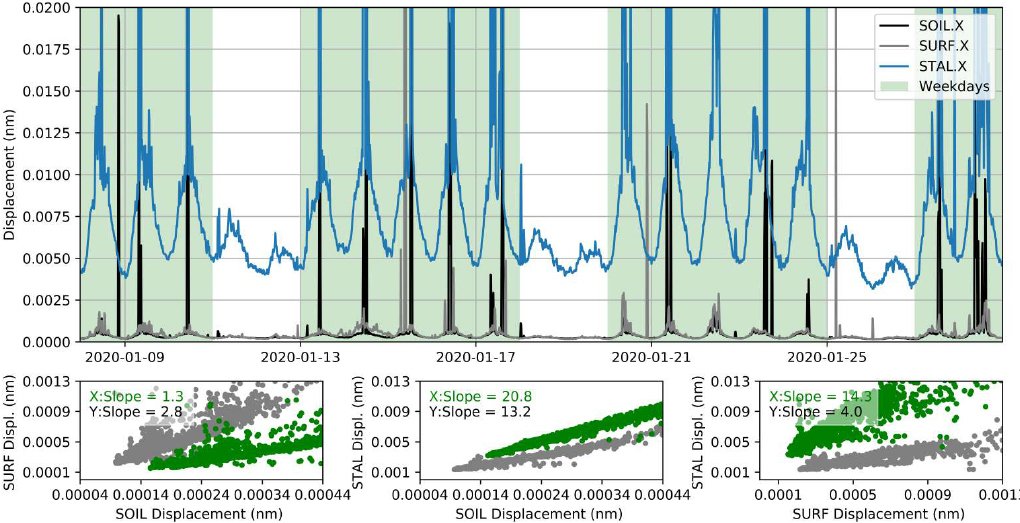
Figure 4. Top : Hourly variations of displacement amplitude (Root Mean Square; RMS) of the ambient seismic noise (11 to 16 Hz, X-component) measured at the surface (SURF, gray) at the base of the stalagmite (SOIL, black) and attached to the stalagmite (STAL, blue), based on [49,50]. Weekdays are indicated by green shading. Bottom : Relation of the displacement amplitudes observed by the three sensors for both horizontal